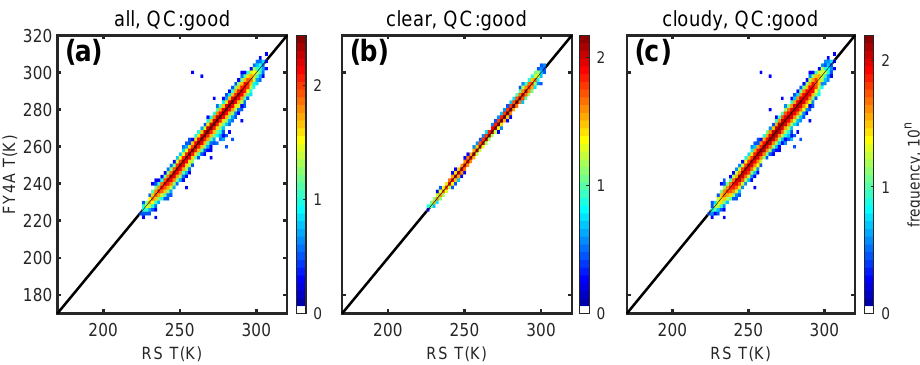
Figure 4. The 2D-histogram plot of FY4A temperature (y-axis) and radiosonde temperature (x-axis).